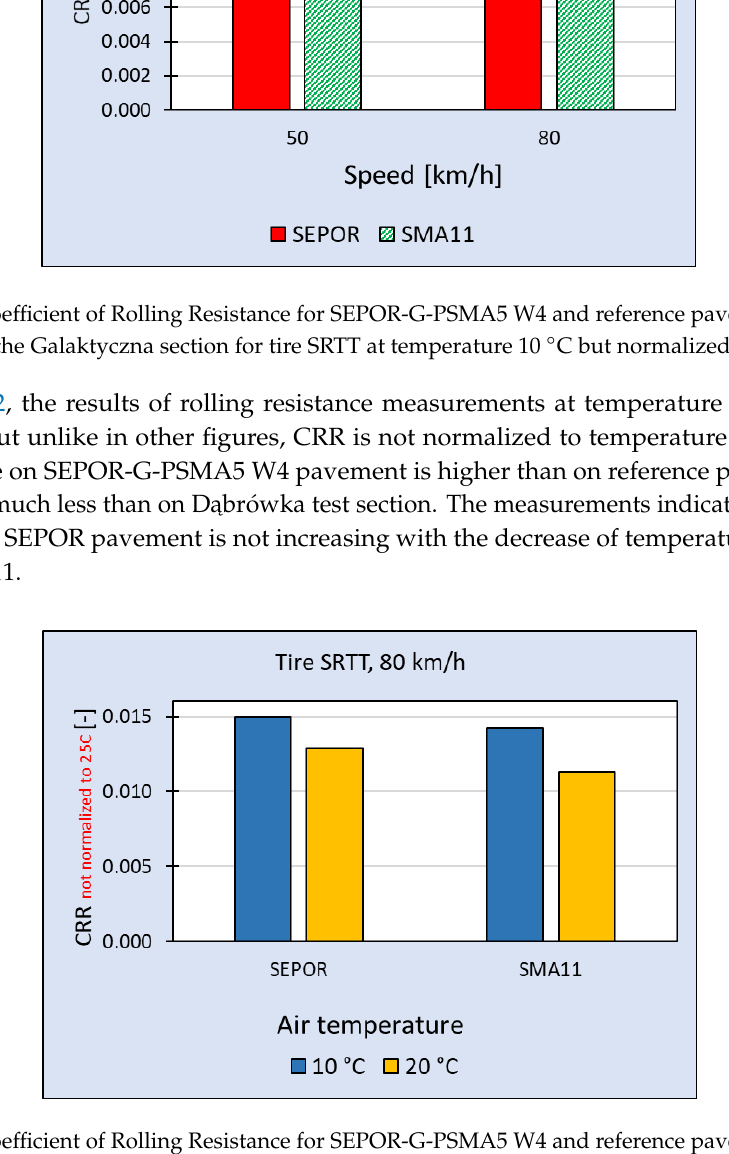
Figure 32. Coefficient of Rolling Resistance for SEPOR-G-PSMA5 W4 and reference pavement SMA11 measured at the Galaktyczna section for tire Avon AV4; values not normalized to 25 °C.